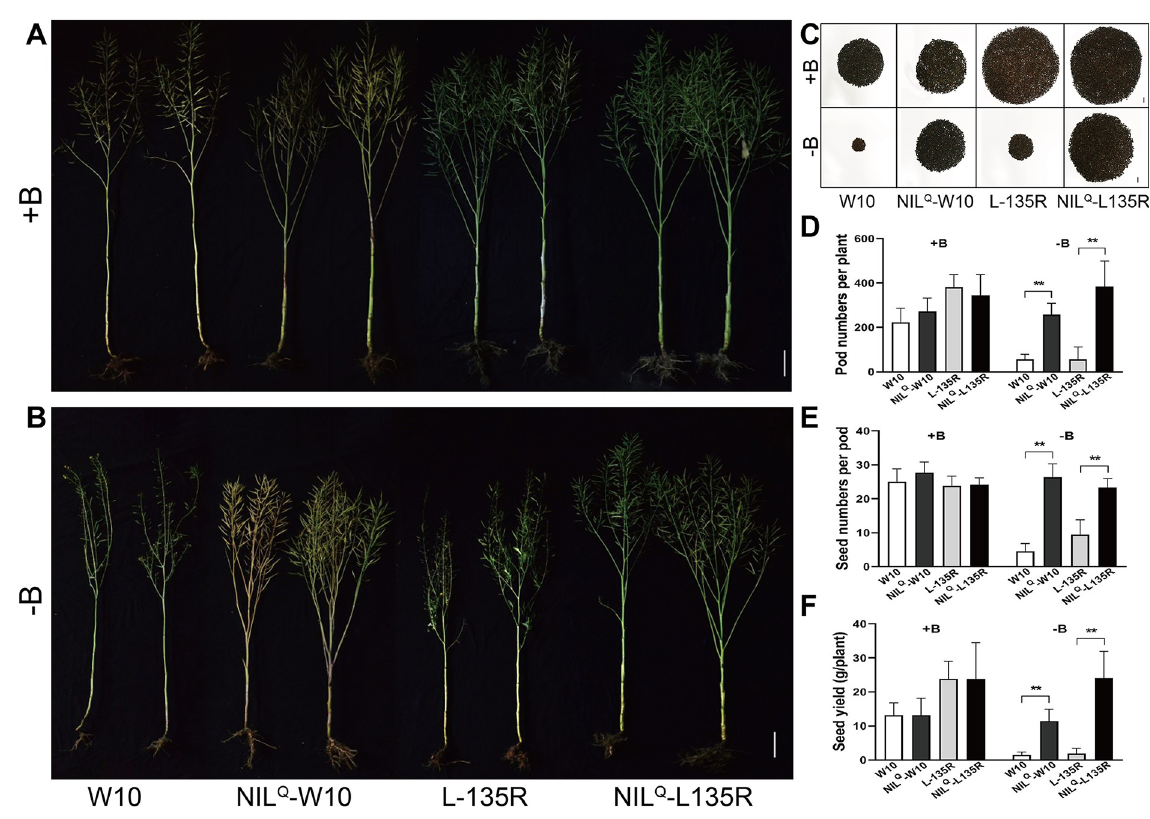
Fig 6. The BnaA3 . NIP3;1 Q allele improves low-B tolerance and seed yields of B . napus . ( A and B ) Phenotypes of W10, NIL Q -W10, L-135R and NIL Q -L135R with B fertilization (+B) ( A ) and without B fertilization (-B) ( B ). Scale bar, 20 cm. ( C ) Total seeds per plant of W10, NIL Q - W10, L-135R and NIL Q -L135R with B fertilization (+B) and without B fertilization (-B). Scale bar, 1 cm. ( D-F ) Statistical comparisons of pod number per plant ( D ), seed number per pod ( E ), and seed yield per plant ( F ). The data presented are mean values with s.d. Twelve biological replicates in ( D-F ). �� P < 0.01 (Student’s t